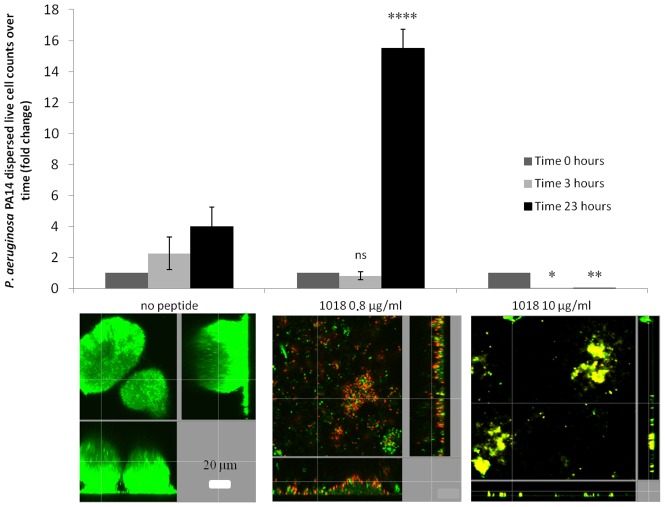
Low levels of 1018 led to biofilm dispersion while higher levels triggered biofilm cell death.Dispersed cells from mature P. aeruginosa flow cell biofilms were collected and viable cell counts performed after 0, 3 and 23 h of treatment with different concentrations of the peptide (0.8 and 10 µg/ml). Representative confocal images of the remaining cells present in the flow cell chambers after peptide treatment are shown for each condition. Statistical significance comparing peptide-treated groups to untreated was determined using Student's t test (ns, P>0.05; *, P<0.05; **, P<0.01; ****, P<0.0001).